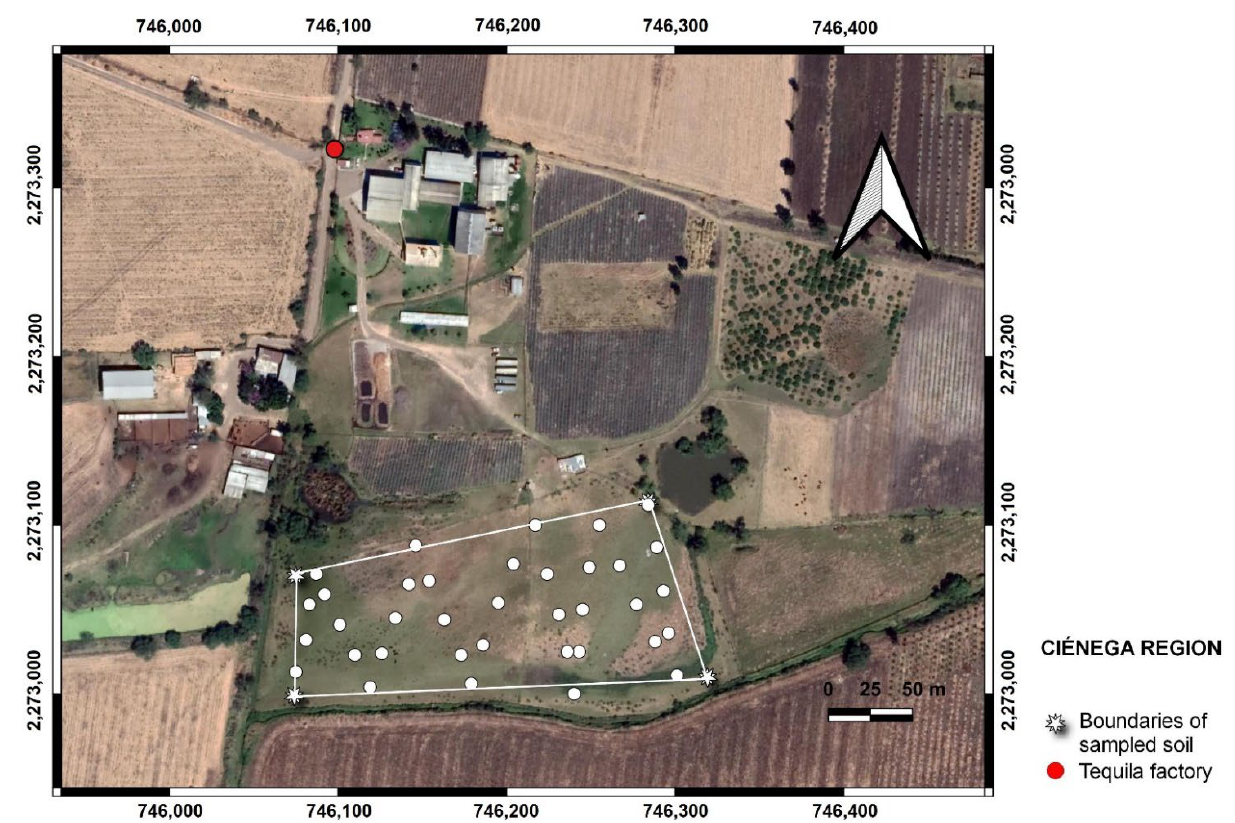
Figure 2. Location of the soil monitored in the Ciénega Region.